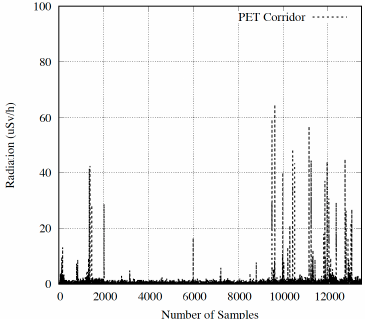
Figure 23. PET corridor results.